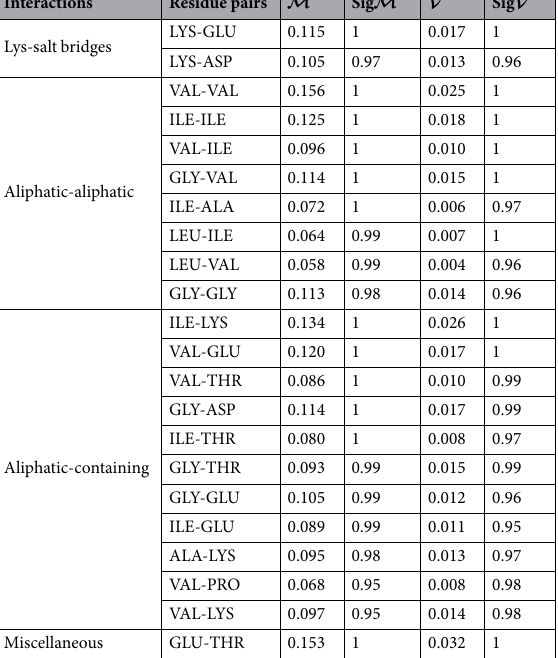
Table 2. Solubilizing residue-residue interactions, defined by  > 0 and the strict significance criteria requiring both | |  and  values to be higher than 95% of the equivalent quantities computed from randomly shuffled datasets (Sig  and Sig ≥ . 0 95 